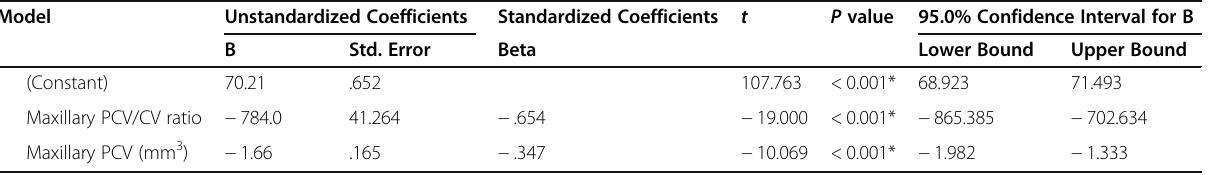
Table 3 Multiple linear regression analysis (forward method) for age prediction by the studied variables